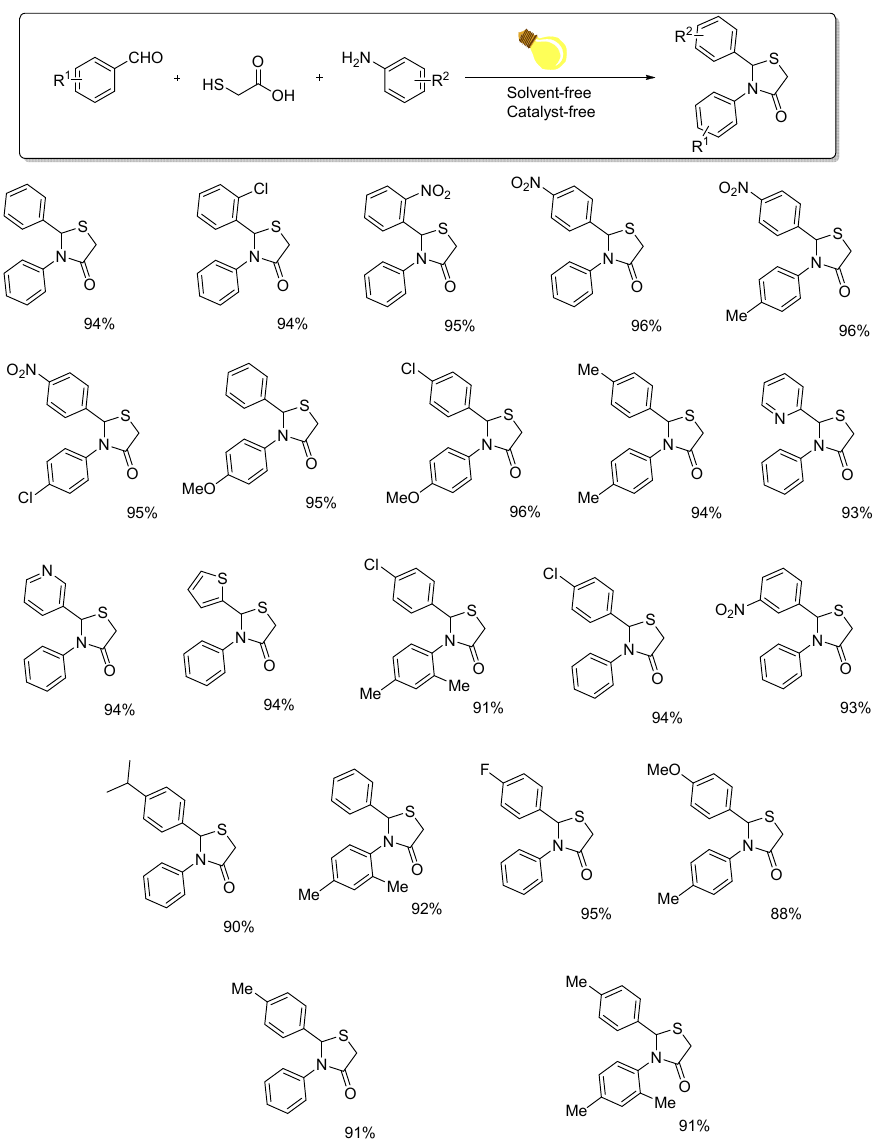
Scheme 21. Photocatalytic synthesis of 1,3-Thiazolidin-4-ones under solvent-free conditions. The yellow bulb-shaped sign indicates irradiation with visible light [147].